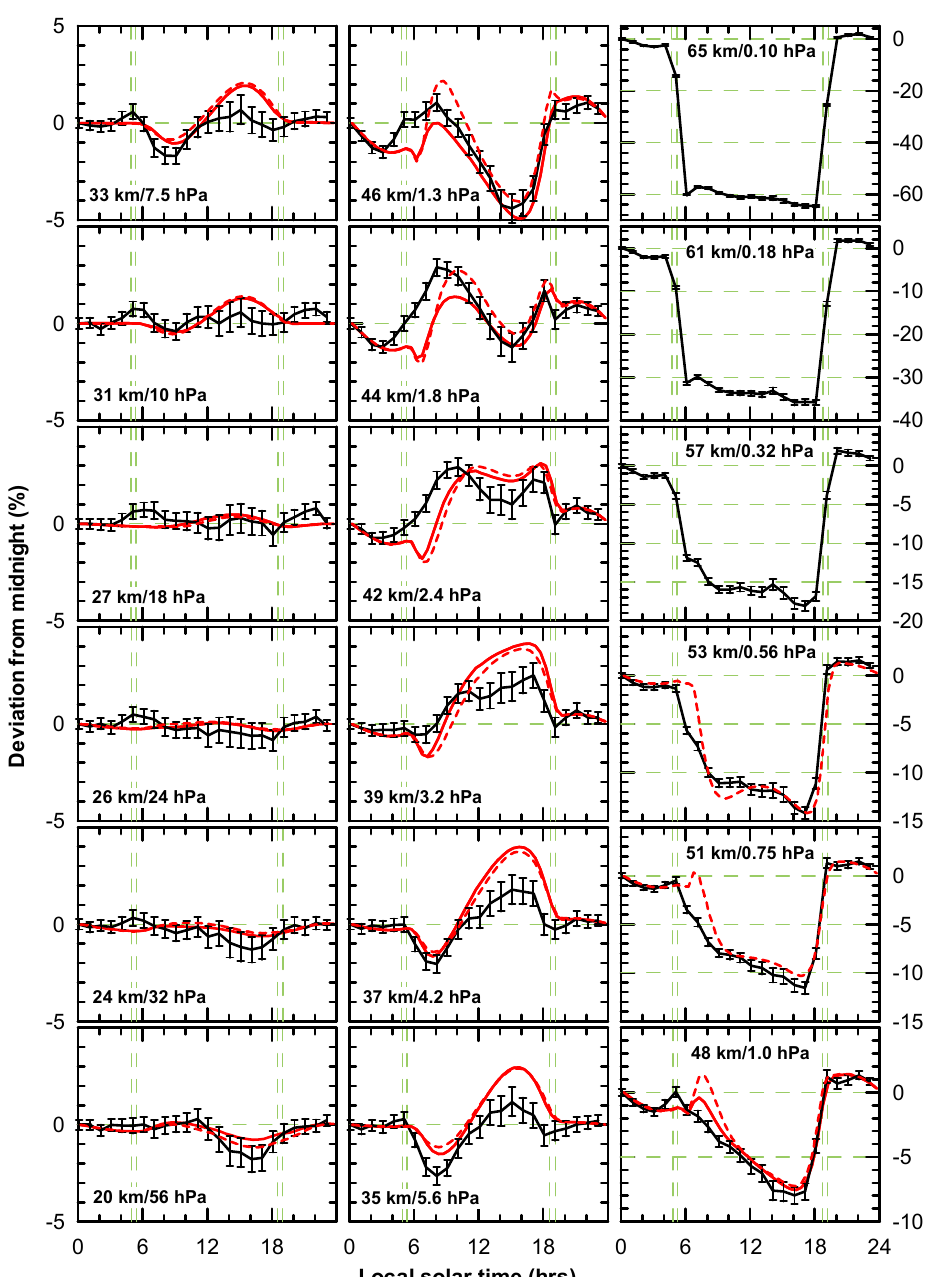
Figure 8. Measured and modeled ozone values for each hour of the day in summer (June, July, and August), normalized to the corresponding midnight values. Measured values (black) are derived from selected MWR data, averaged over the summer months from 1995 to 2013, at pressure levels between 56hPa (bottom left panel) and 0.1hPa (top right panel). The scales for the panels from 1 to 0.1hPa are given on the right hand ordinates; the scales for all others are given on the left hand ordinates. All values have been normalized to the midnight value as described in Sect. 2.1. Two standard deviation statistical error estimates described in the text are shown as error bars. The original output from the NASA/GSFC GEOSCCM STRATTROP model outputs for 2005 are shown by the dashed red lines. Solid red lines show the model outputs after convolution with the MWR averaging kernels. Dashed green vertical lines indicate the earliest and latest sunrise times at the given